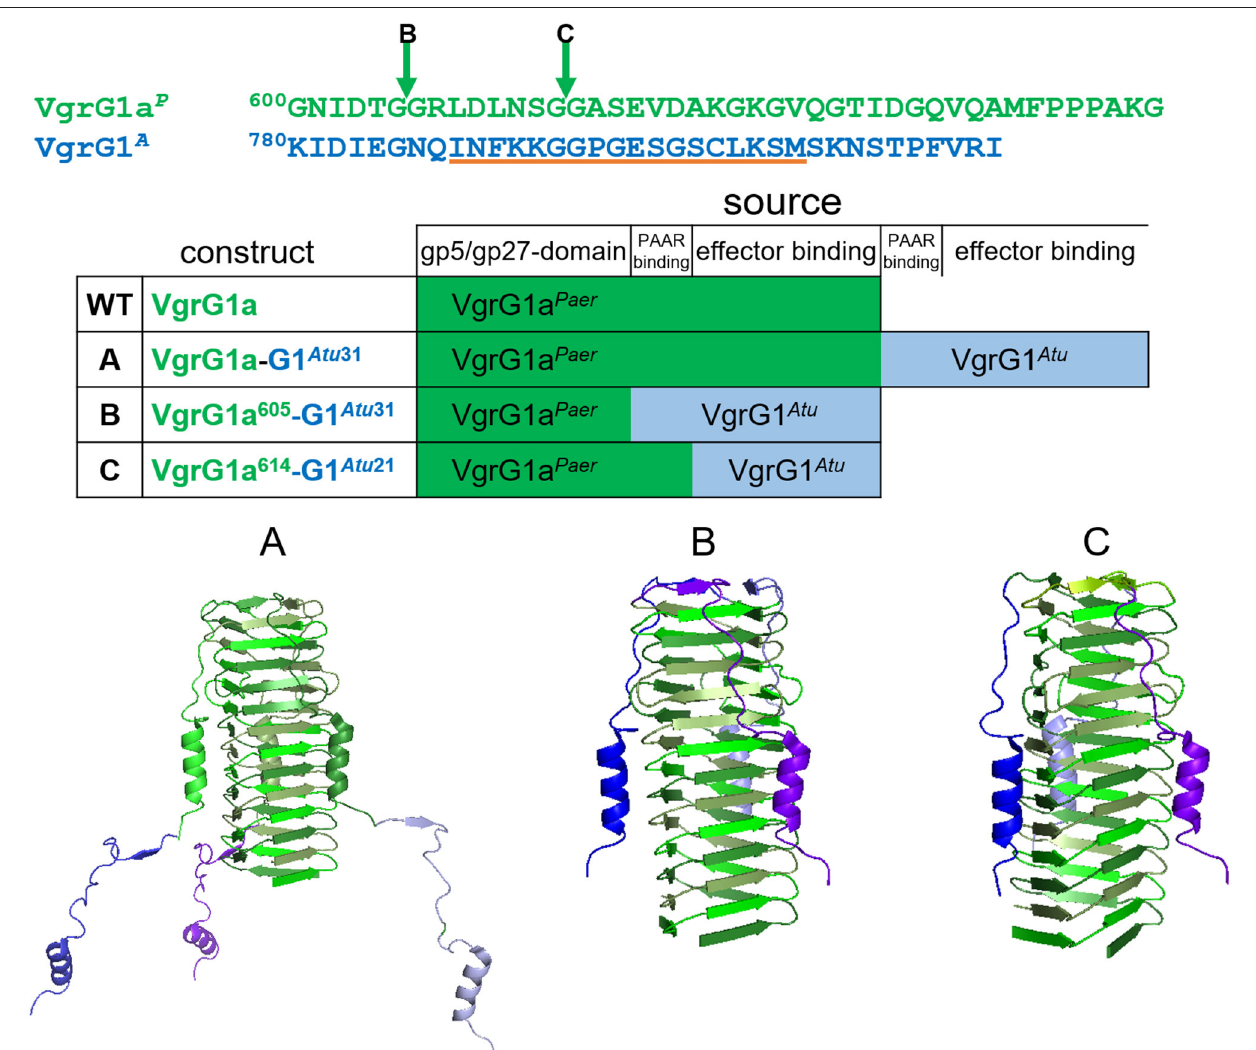
FIGURE 2 | Construction of VgrG chimeras. The top panel represents the amino acid sequences of the C-terminal extensions of VgrG1a P (green) and VgrG1 A (blue). The arrows correspond to the swapping points after amino acid (aa) 605 in chimera B and aa 614 in chimera C. The orange line corresponds to the epitope, against which the VgrG1 antibody was raised. In the lower panel structural models (pdb:4mtk) of the needle parts of the three designed chimeras are shown. In construct A, the STOP codon of vgrG1a P (green) was replaced by the gene portion corresponding to the last 31 aa of VgrG1 A (blue). Constructs B,C were designed by substituting the gene portions corresponding to the last 35 aa and 29 aa of vgrG1a P with the gene portions corresponding to the last 31 aa and 21 aa, respectively, of VgrG1 A .